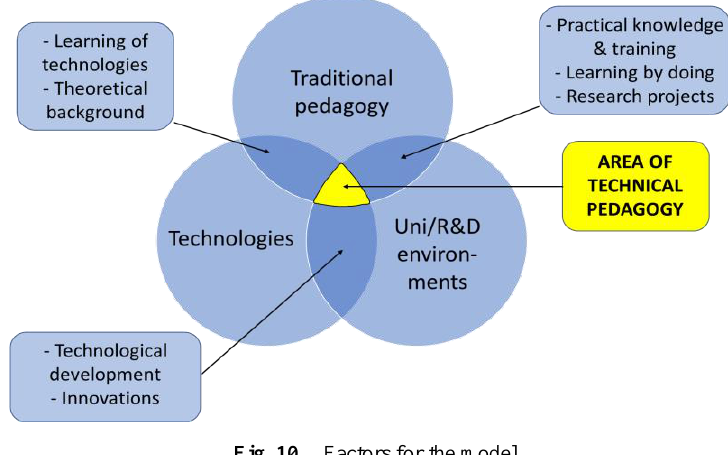
Fig. 10. Factors for the